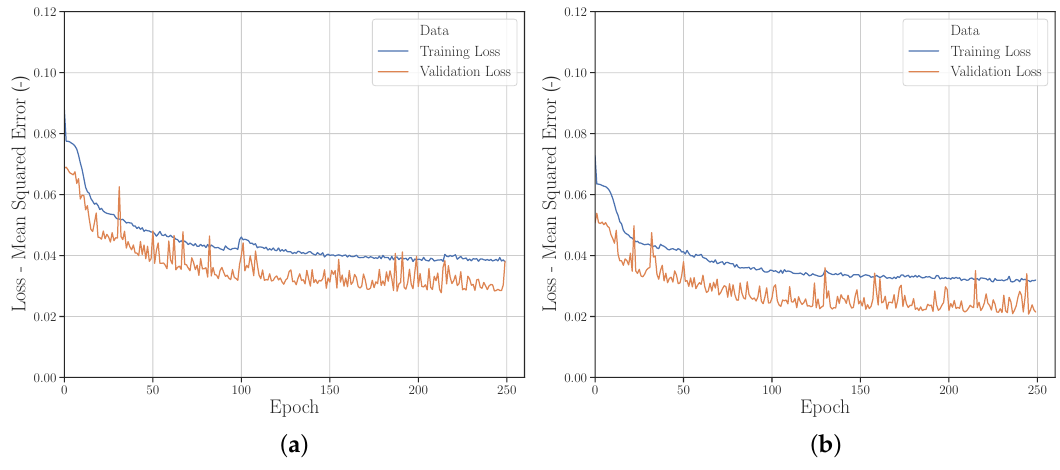
Figure 8. Learning curves from ( a ) Run_1 and ( b ) Run_2